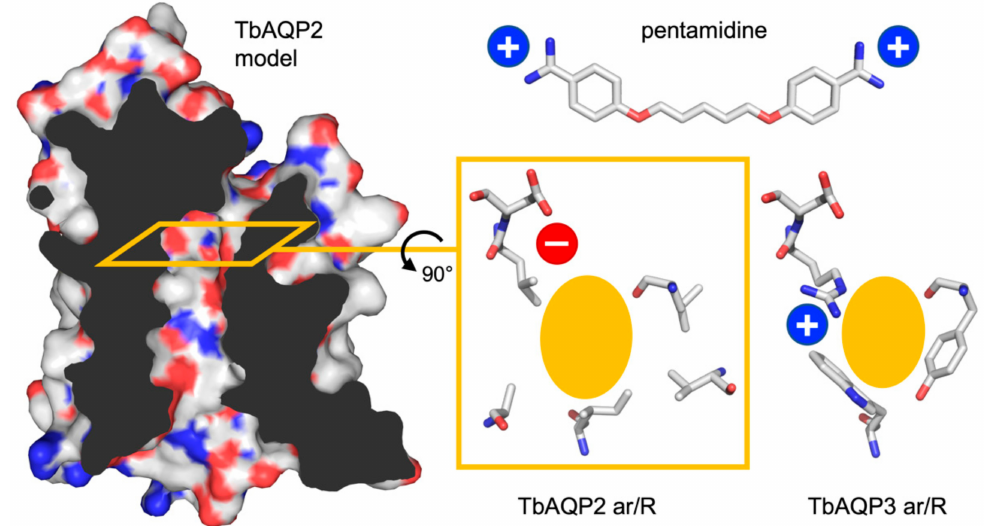
Figure 1. Pentamidine and structure models of TbAQP2 and TbAQP3. The TbAQP2 protomer model based on the Escherichia coli aquaglyceroporin GlpF (PDB #1fx8) is shown as a side view and clipped to display the water / solute transduction pathway. The plane of the selectivity filter (aromatic arginine region, ar / R) is indicated by the orange rectangle. The layouts of the TbAQP2 and TbAQP3 ar / R regions are shown in top down view and the pentamidine molecule is drawn to